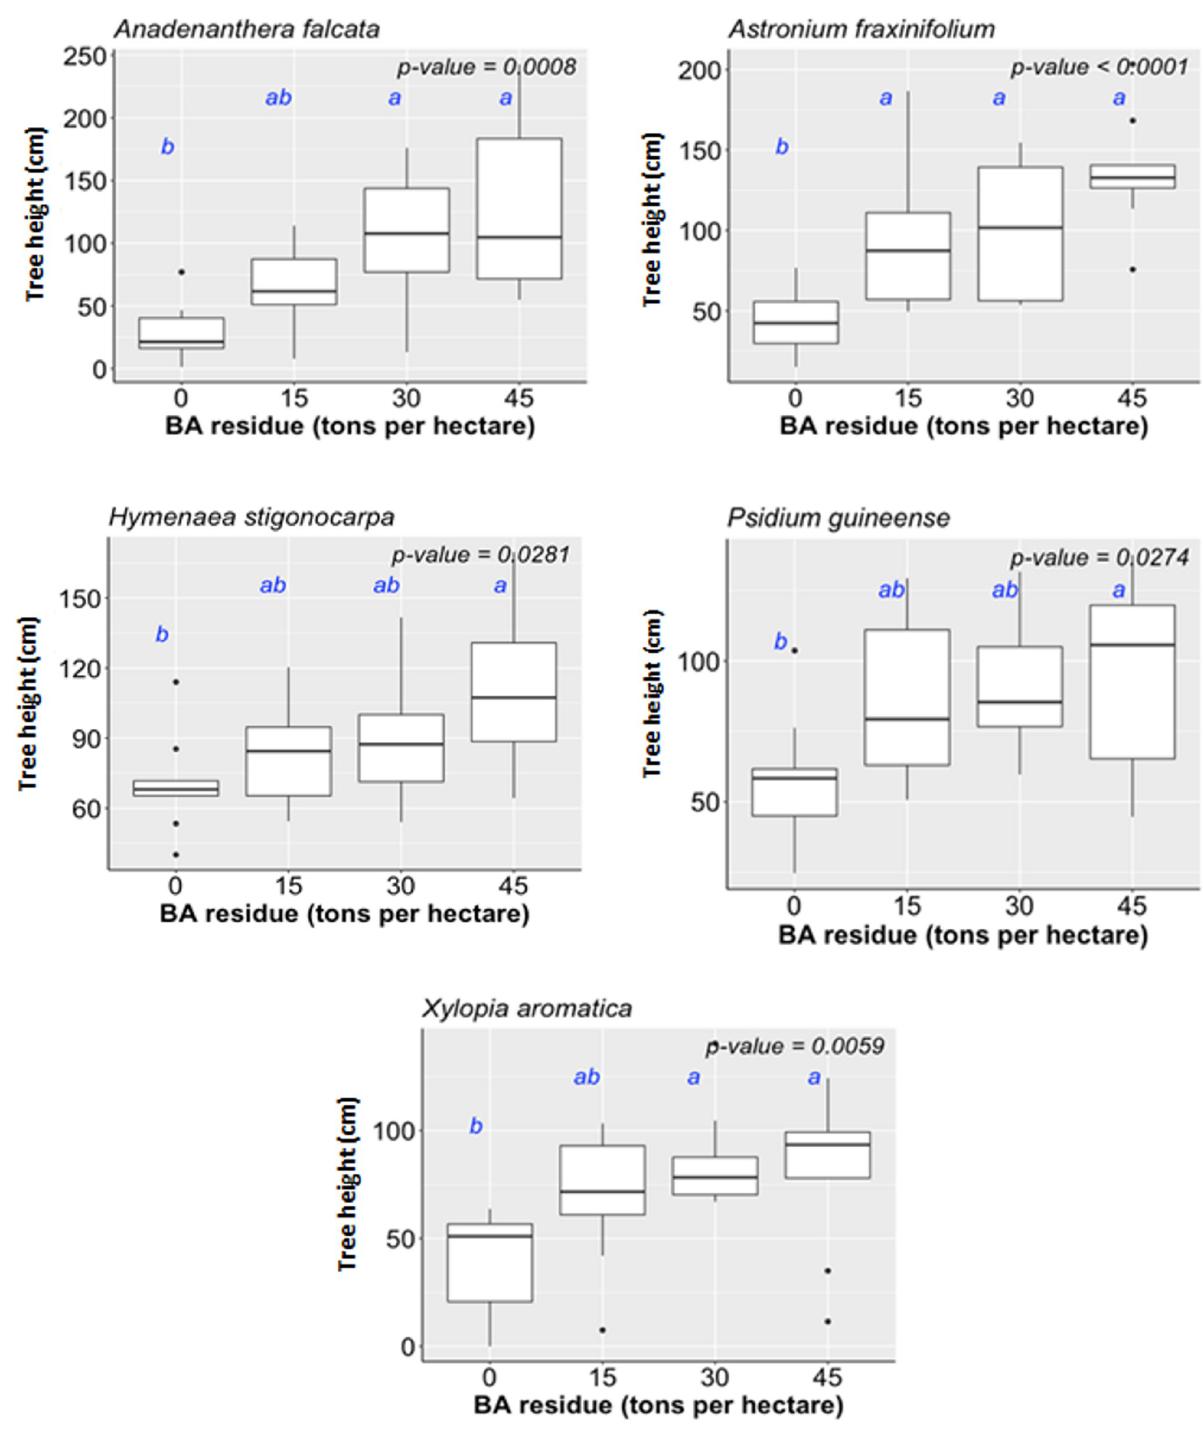
Fig 6. Influences of BA residues on tree height.